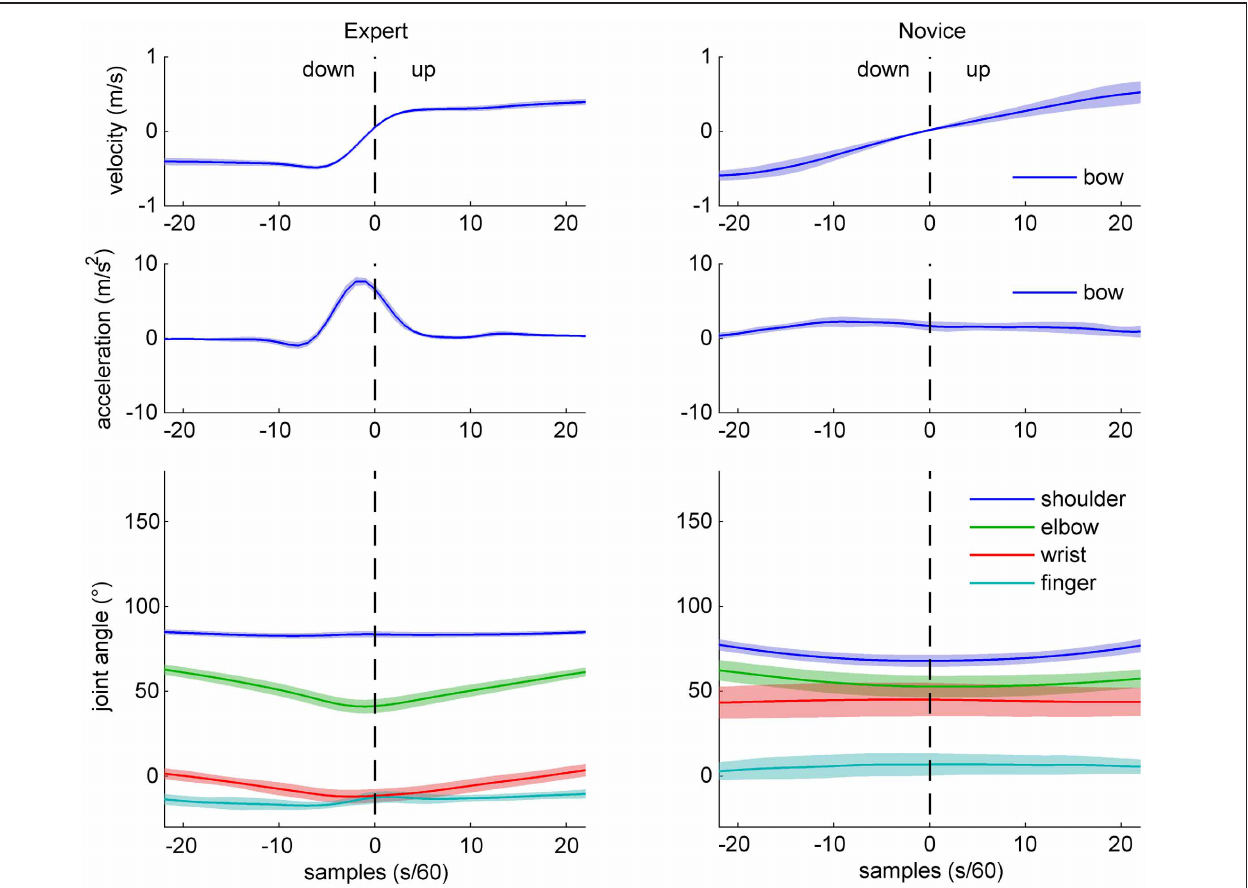
FIGURE 3 | Sample data of bow kinematics (velocity and acceleration) and joint angle movement for an expert (left) and a novice (right) cello player, during a down-up bow reversal. Shaded areas indicate SD across movements.